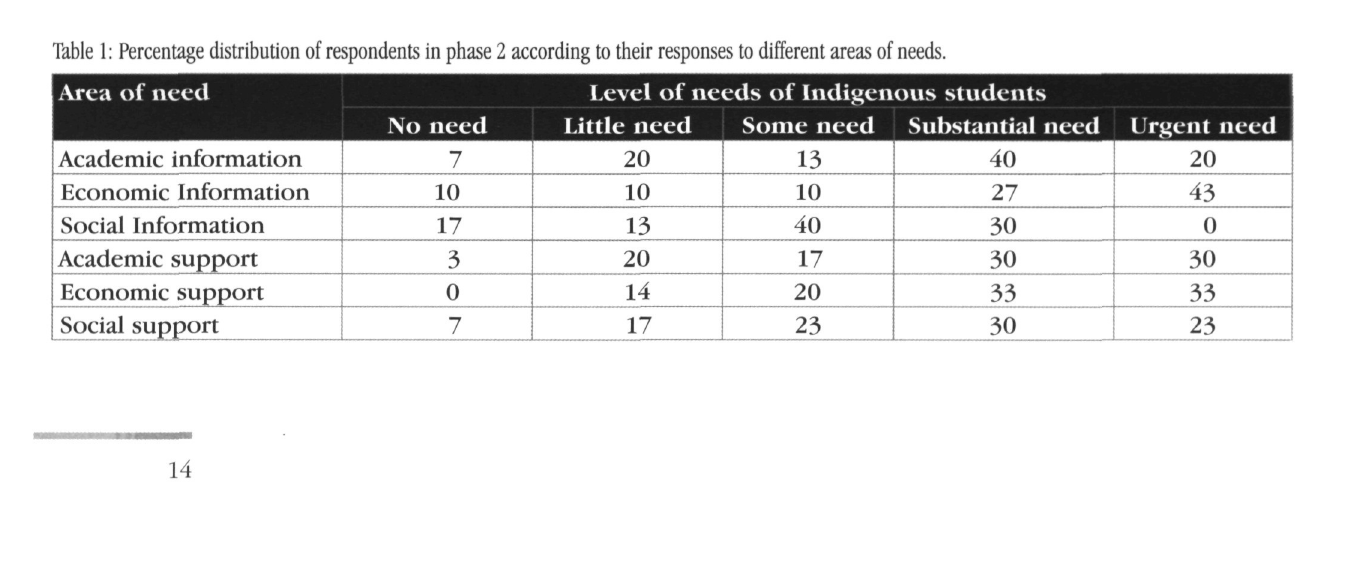
Table 1: Percentage distribution of respondents in phase 2 according to their responses to different areas of needs. Area of